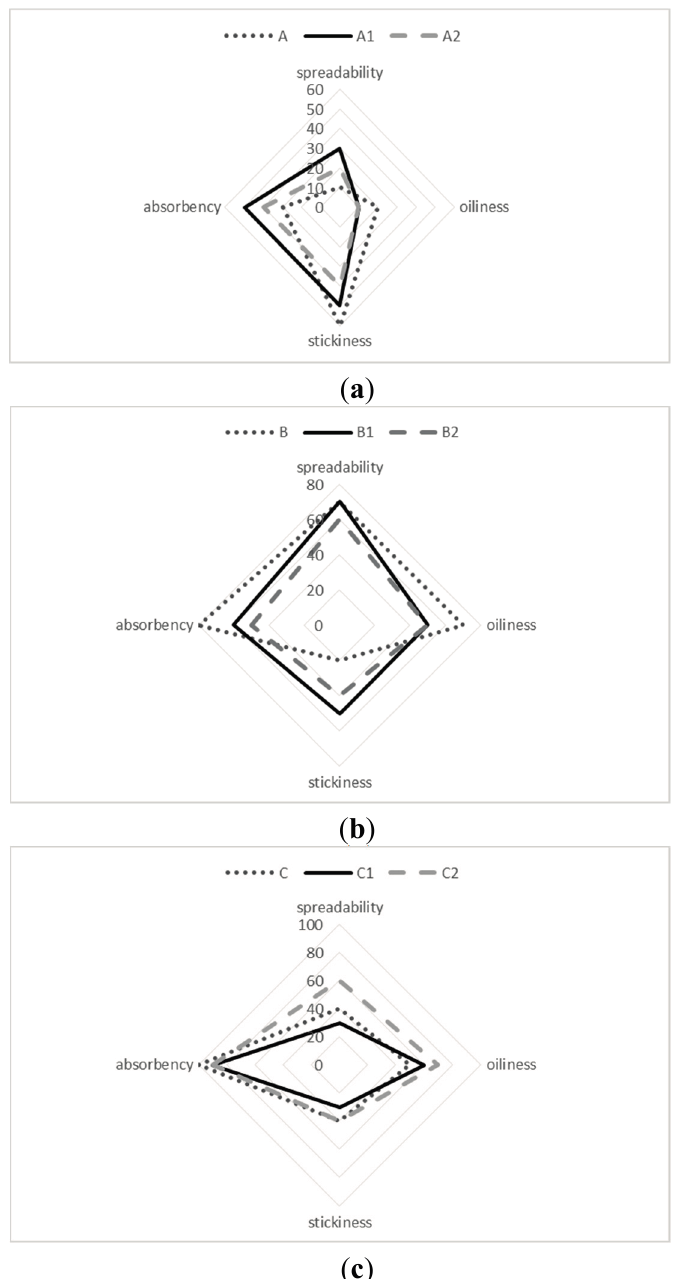
Figure 1. Sensory evaluation of emulsions A-C during the application on the skin. ( a ) emulsions A, A1 and A2; ( b ) emulsions B, B1 and B2; ( c ) emulsions C, C1,